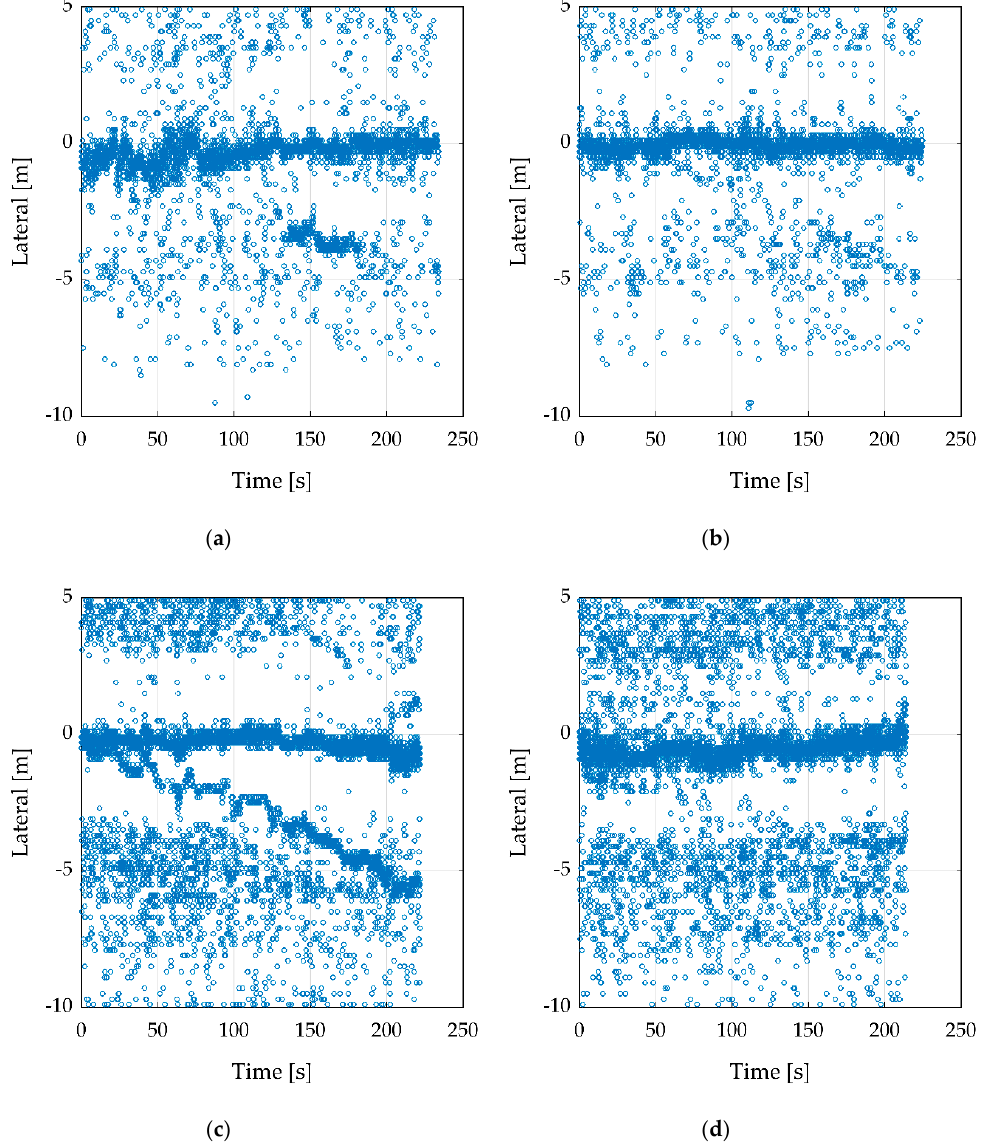
Figure 10. Recording flight in 10 m height over two corner cube reflectors. One reflector position is fixed, the second reflector was pulled away by 50 cm steps. ( a , b ) with the radar sensor ARS-404, ( c , d ) with ARS-408. The RCS of the reflector is in ( a , c ) 27.6 m 2 and ( b , d ) 1.7 m 2 . Table 5. Filter setup for Figure 10 with min and max